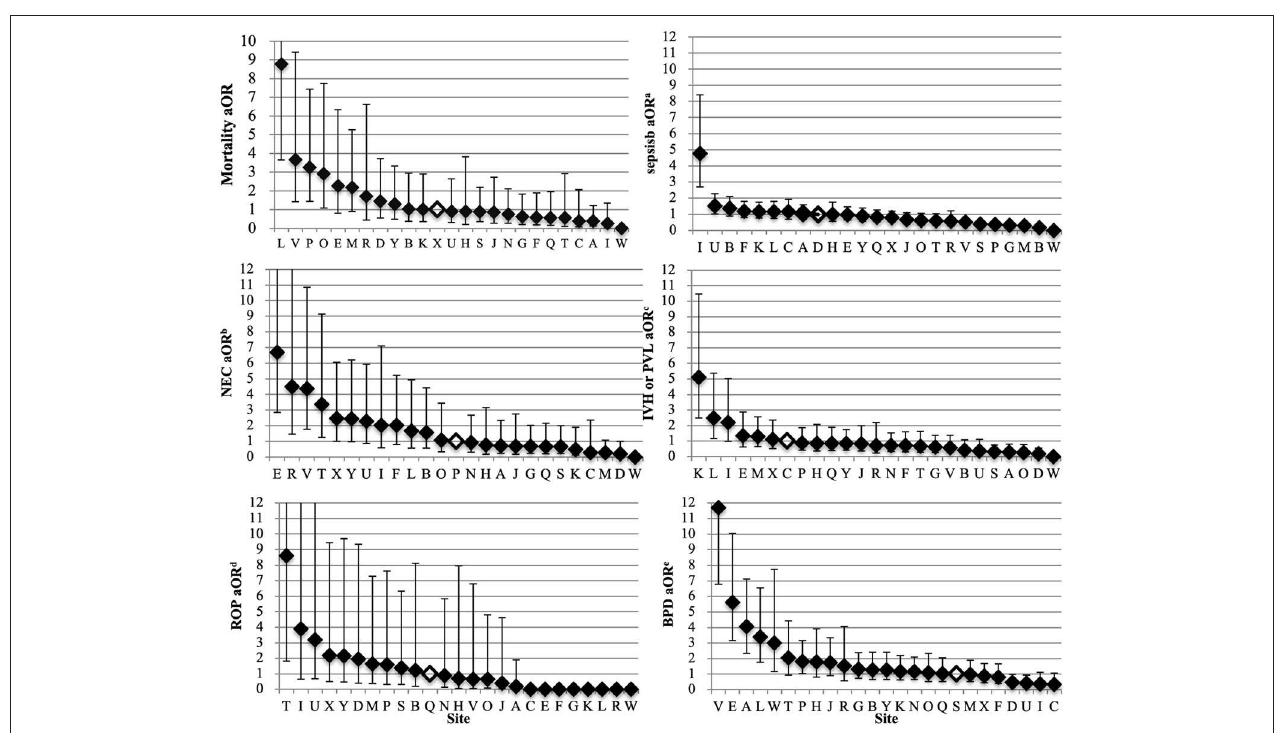
FIGURE 3 | Variation by NICU of mortality and morbidity of infants born at < 34 weeks’ gestation who received complete care. The NICU with the median outcome rate was used as the reference site for the multi-regression model (open diamond). The adjusted covariates were sex, gestational age, small for gestational age, Apgar score < 3 at 5min, TRIPS score on admission, inborn, cesarean, maternal hypertension, maternal diabetes and antenatal steroids. Error bars indicate 95% confidence intervals. NICUs, neonatal intensive care units; aOR, adjusted odds ratios; NEC, necrotizing enterocolitis; IVH, intraventricular hemorrhage; PVL, periventricular leukomalacia; ROP, retinopathy of prematurity; BPD, bronchopulmonary dysplasia. a Sepsis included both culture-proven sepsis and clinical sepsis. b Included all infants who survived 72h. NEC was defined as NEC ≥ stage 2 according to Bell’s criteria. c Included all infants with neuroimaging results. IVH was defined as IVH ≥ grade 3 according to Papile et al. or PVL. d Included all infants with eye examinations. ROP was defined as ≥ stage 3 according to international classification of ROP. e BPD was defined as requiring mechanical ventilation or oxygen dependency at 36 weeks’ postmenstrual age or